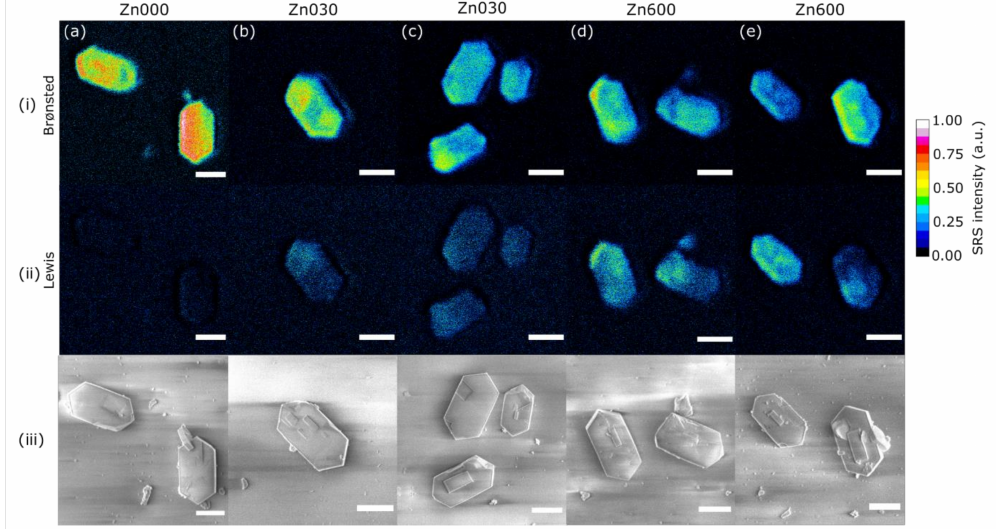
Figure 3. SRS mapping of ( i ) pyridinium cation (I 1006 ) and ( ii ) complexed pyridine (I 1023 − I 1006 [I 1023 / I 1006 ] Zn000 , see supporting information for details) and ( iii ) SEM image of the corresponding morphology for ZSM-5 crystals at di ff erent exchange time. ( a ) Zn000, ( b , c ) Zn030, and ( d , e )